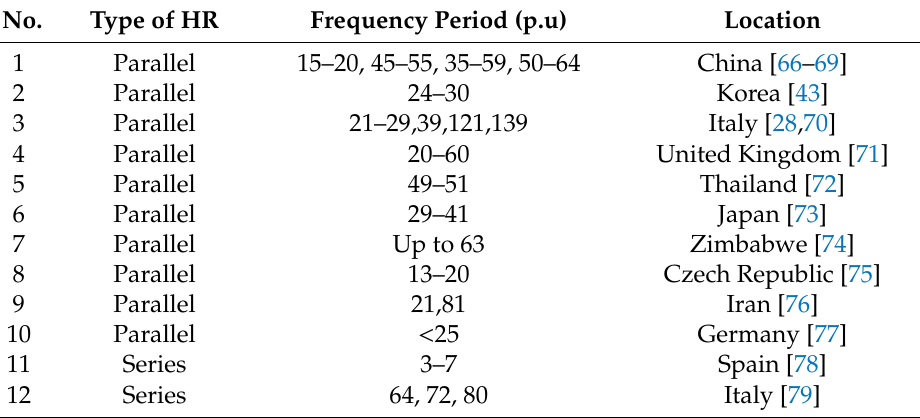
Table 1. Di ff erent types of reported harmonic resonance (HR) in the